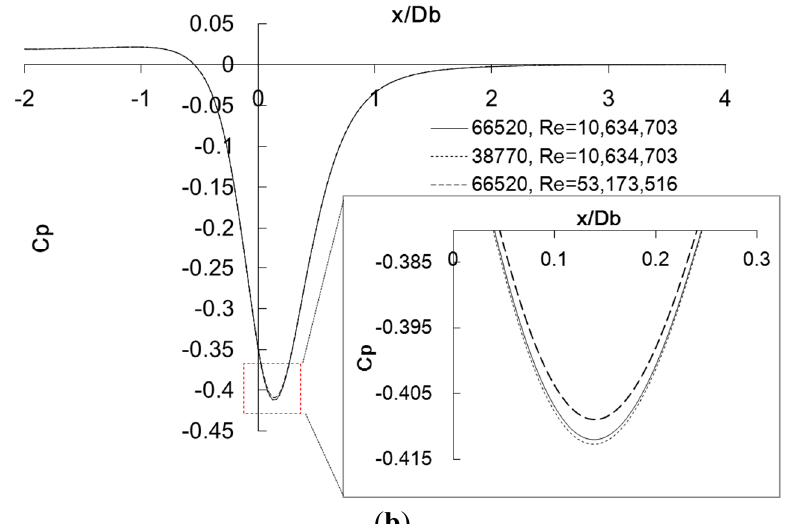
Figure 10. Effects of grid number and Reynolds number on the distributions of streamwise velocity and pressure coefficient along the axisymmetric axis in the case of the diffuser with a rigid and flat flange (Figure 8a): ( a ) streamwise velocity and ( b ) pressure coefficient.